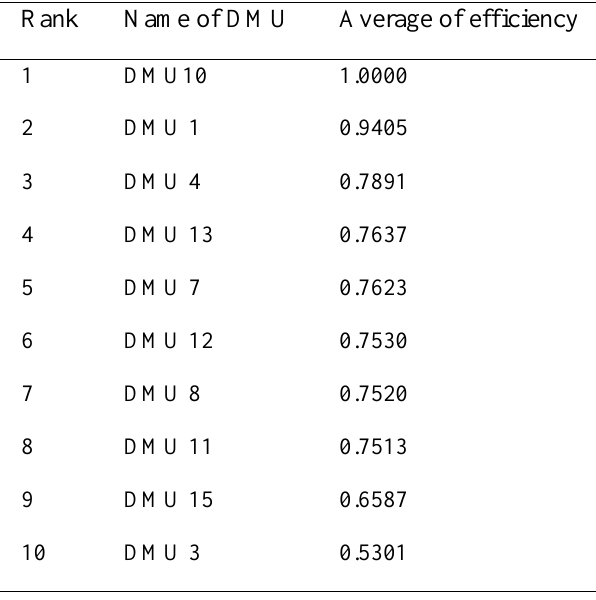
Figure 7. Average Efficiency of each DMU. Table 2. Ranking of